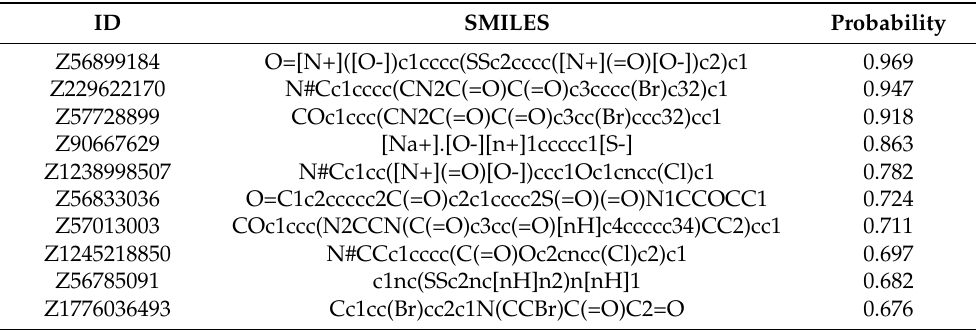
Table 2. The predicted lead compounds for SARS-CoV-2